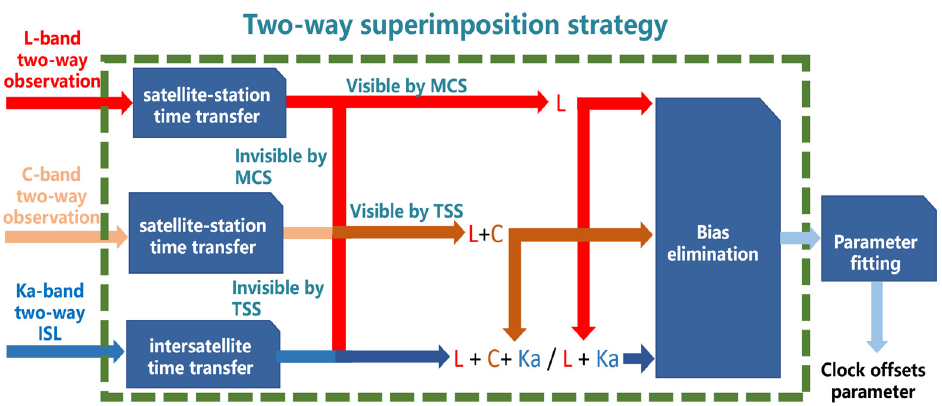
Figure 2. The procedure of the BDS-3 two-way superimposition strategy.